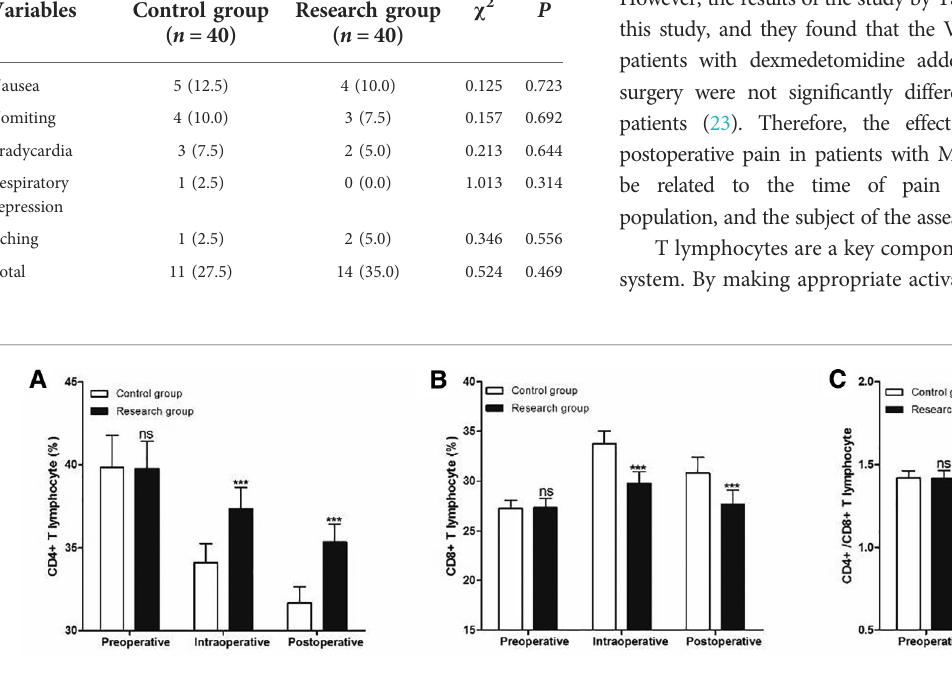
FIGURE 5 Perioperative peripheral blood T lymphocyte subsets at different timepoints. ( A ) CD4 T lymphocyte, ( B ) CD8 T lymphocyte and ( C ) CD4+/CD8+ T lymphocyte. Compared with Control group, ns P >0.05 and *** P <0.001.